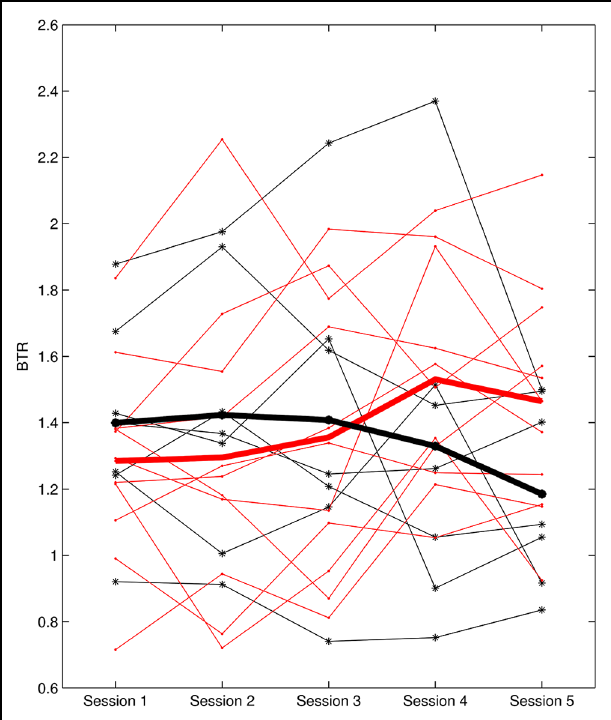
FIGURE 4 | BTR across sessions of learner_L2 and non-learner_L2. Thin red lines with dot represent BTR of each learner; thick red line depicts the mean BTR across all learners; thin black lines with star show each non-learner; thick black line shows the mean across non-learners.